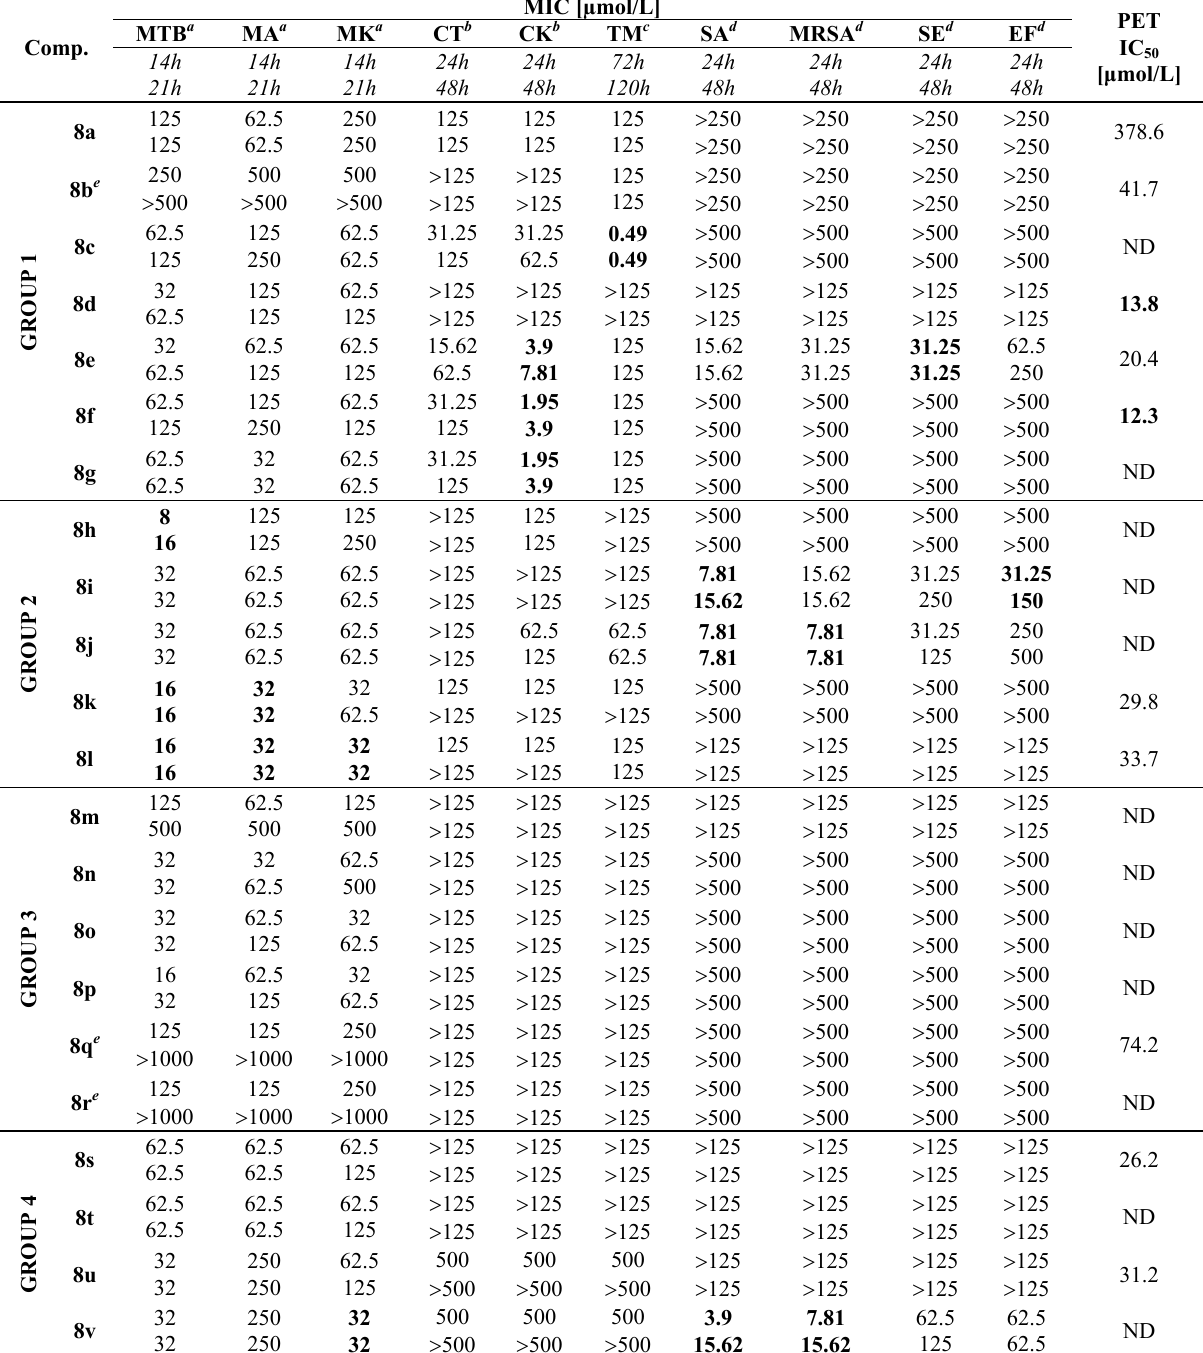
Table 2. Antimycobacterial activity (MIC/IC ) of compounds in comparison with 90 or IC ) isoniazid (INH) standard; in vitro antifungal and antibacterial activity (MIC/IC 50 90 of compounds compared with fluconazole (FLU), penicillin G (PEN) and ciprofloxacin (CPF) standards; and IC values of discussed compounds related to photosynthetic 50 electron transport (PET) inhibition in spinach chloroplasts in comparison with 3-(3,4- dichlorophenyl)-1,1-dimethylurea (DCMU)